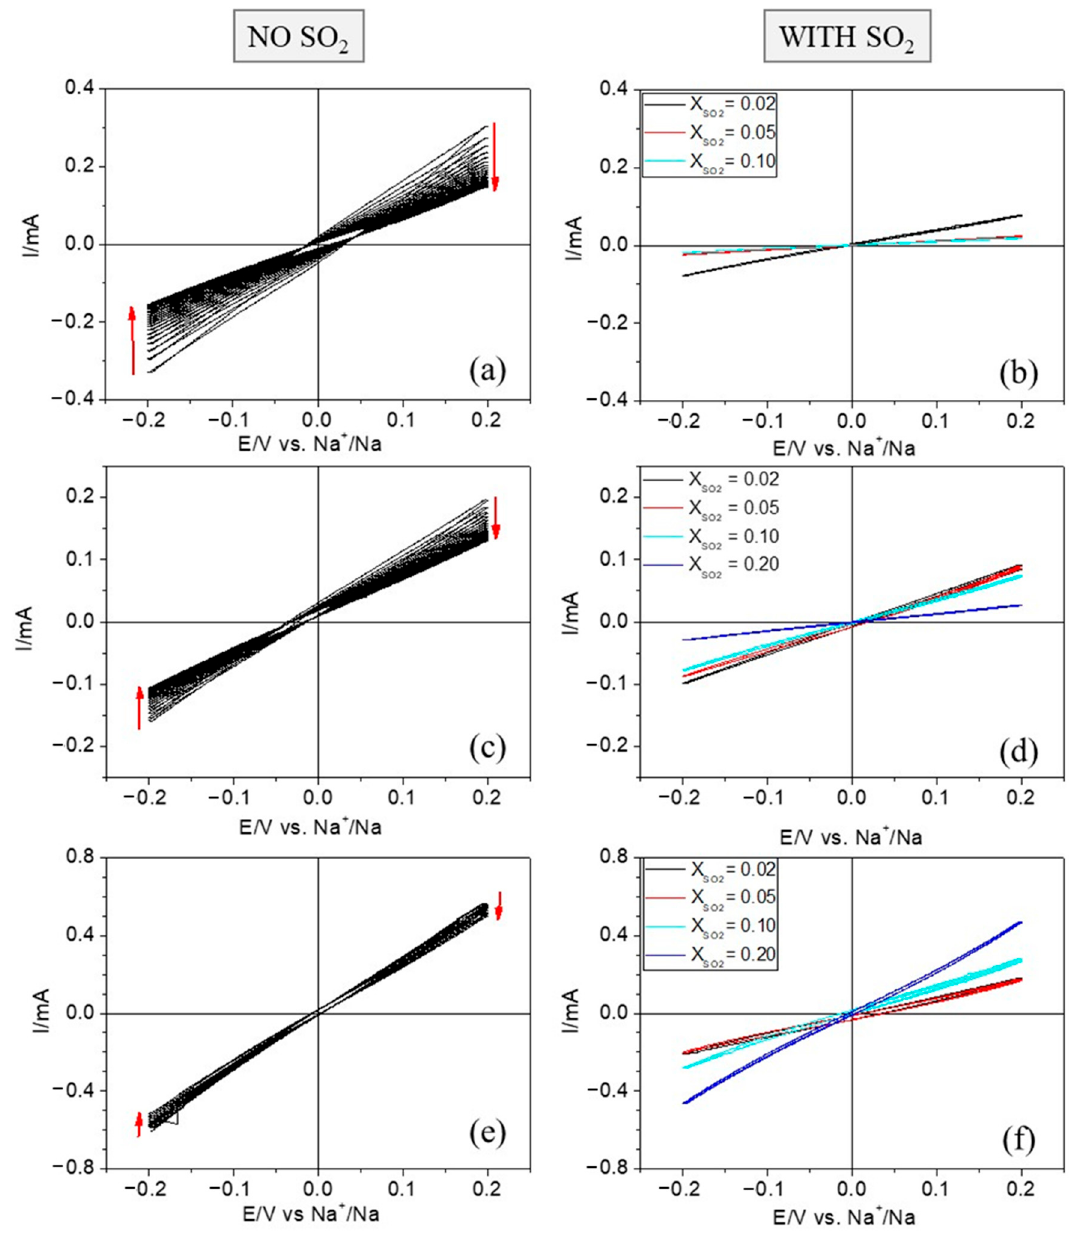
Figure 1. Cyclic voltammograms in the presence and the absence of SO 2 for Na electrodes in different organic electrolytes: ( a ) 2 M NaTf/DOL:DME, ( b ) 1.6 M NaTf/DOL:DME; ( c , d ) 2 M NaSCN/DOL:DME and ( e , f ) 1 M NaClO 4 /PC at 20 mV s − 1 .